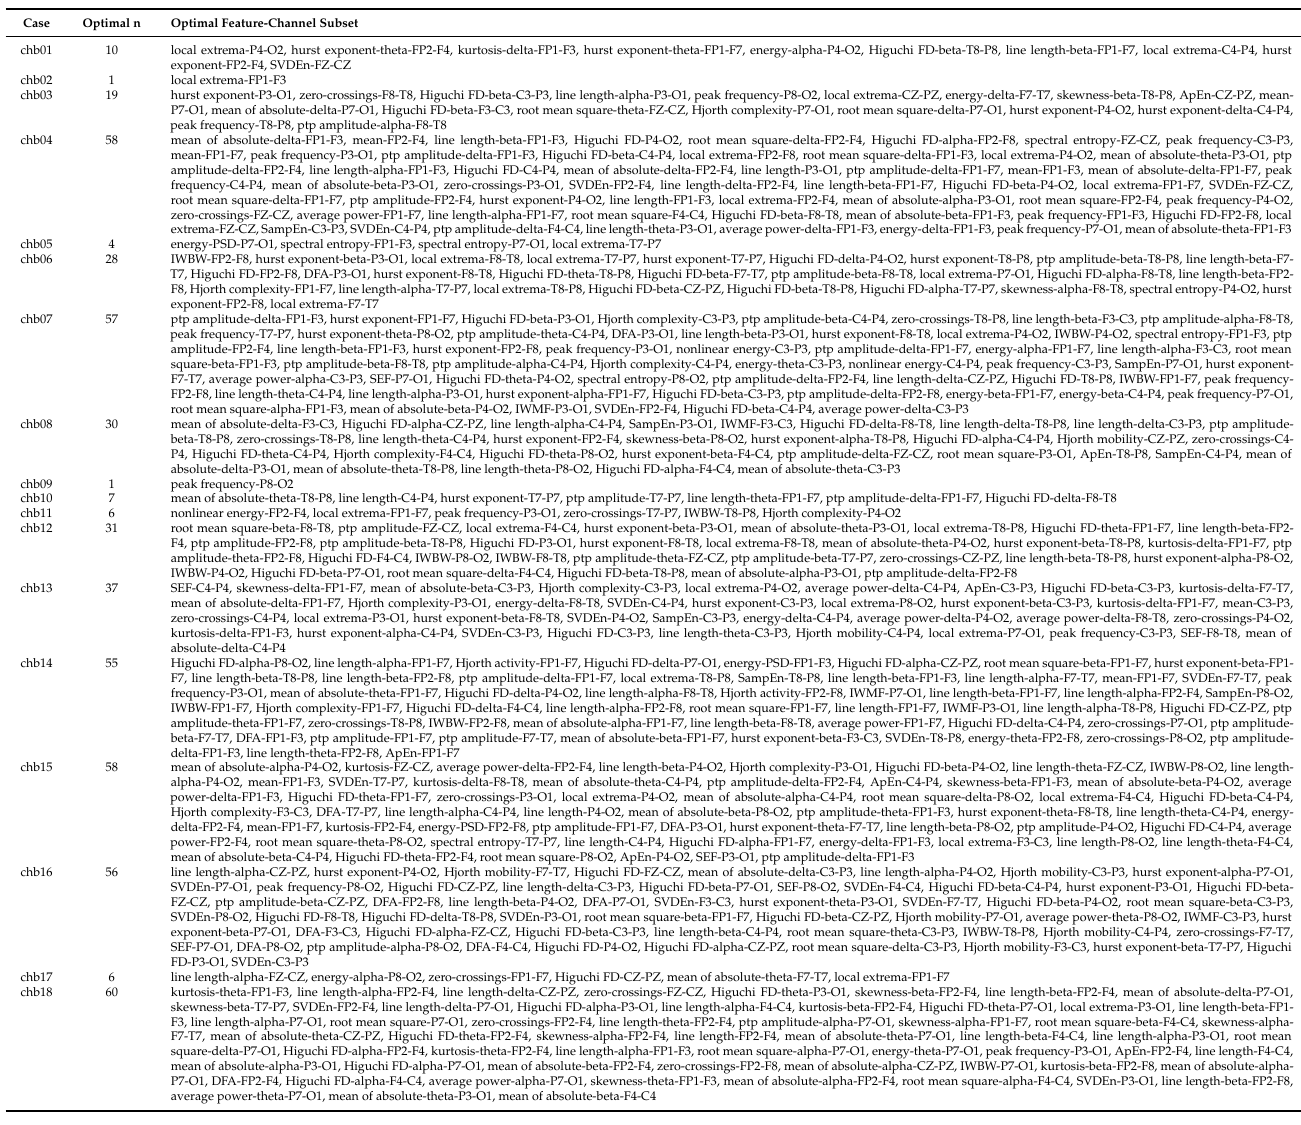
Table A1. Optimal feature-channel combinations for every patient. In time and frequency domains, feature_name- channel_name denotes the channel-based feature. In time–frequency domain, feature_name-pattern_name-channel_name to represent